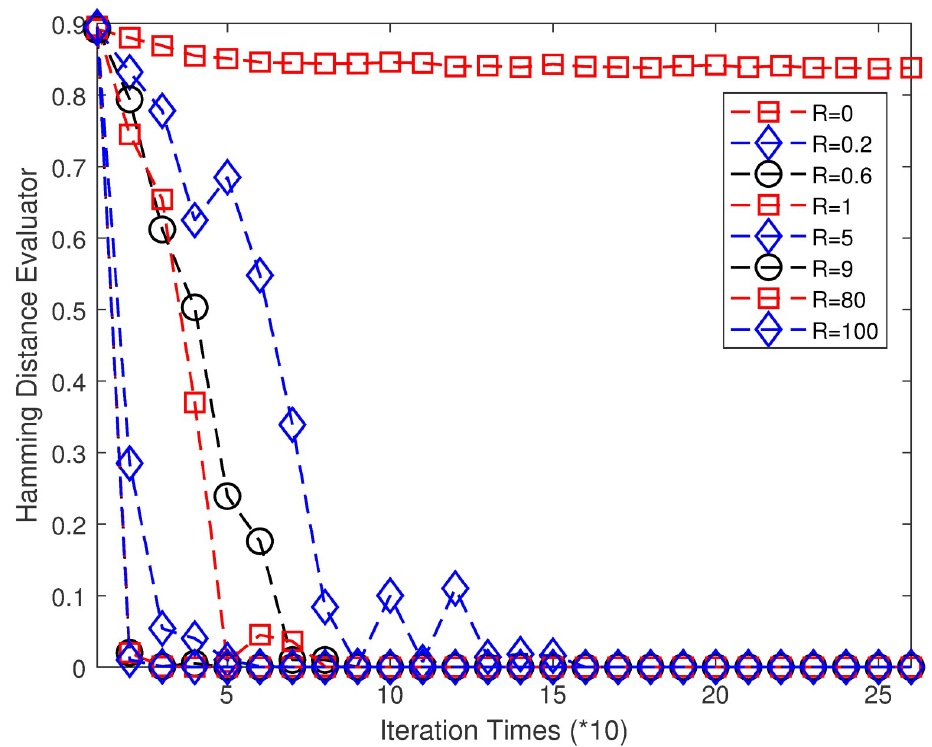
Fig 9. HDE curves over the iteration times for several values of R .